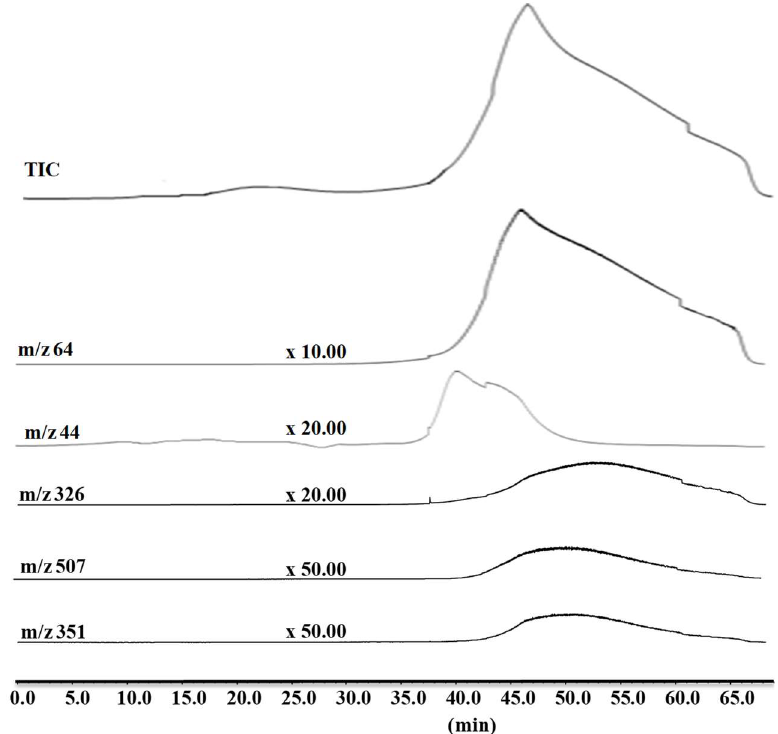
Figure 7. TIC trace and SIC curves of the ions at m / z 44, 64, 326, 351 and 507 recorded during the EI-DPMS of the random copolymer P(ESES)-co-(ESDPA) 50/50.